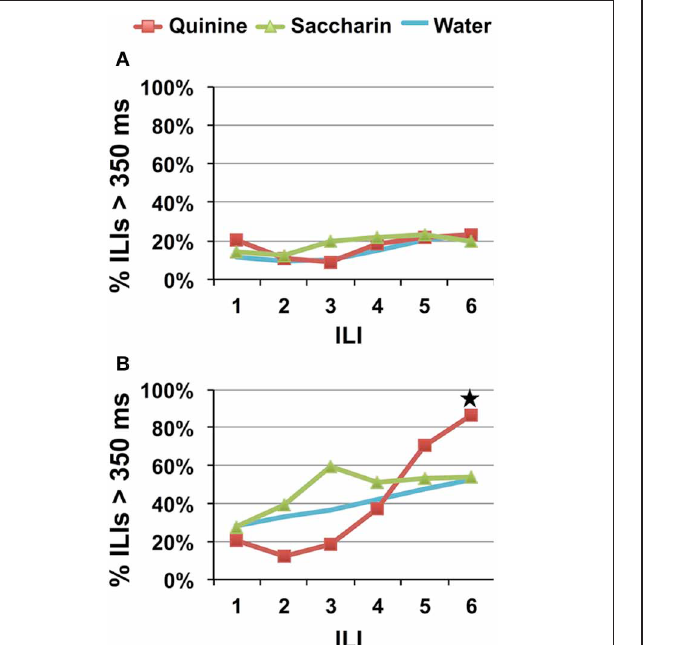
FIGURE 6 | Speed of quinine identification when only saccharin and quinine were presented. Percentage of ILI’s above 350ms. Each stimulus was presented for a single lick. All rats were untrained. (A) Quinine was presented at 0.1mM. (B) Quinine was presented at 10mM. Star indicates significant difference at p < 0 . 05.